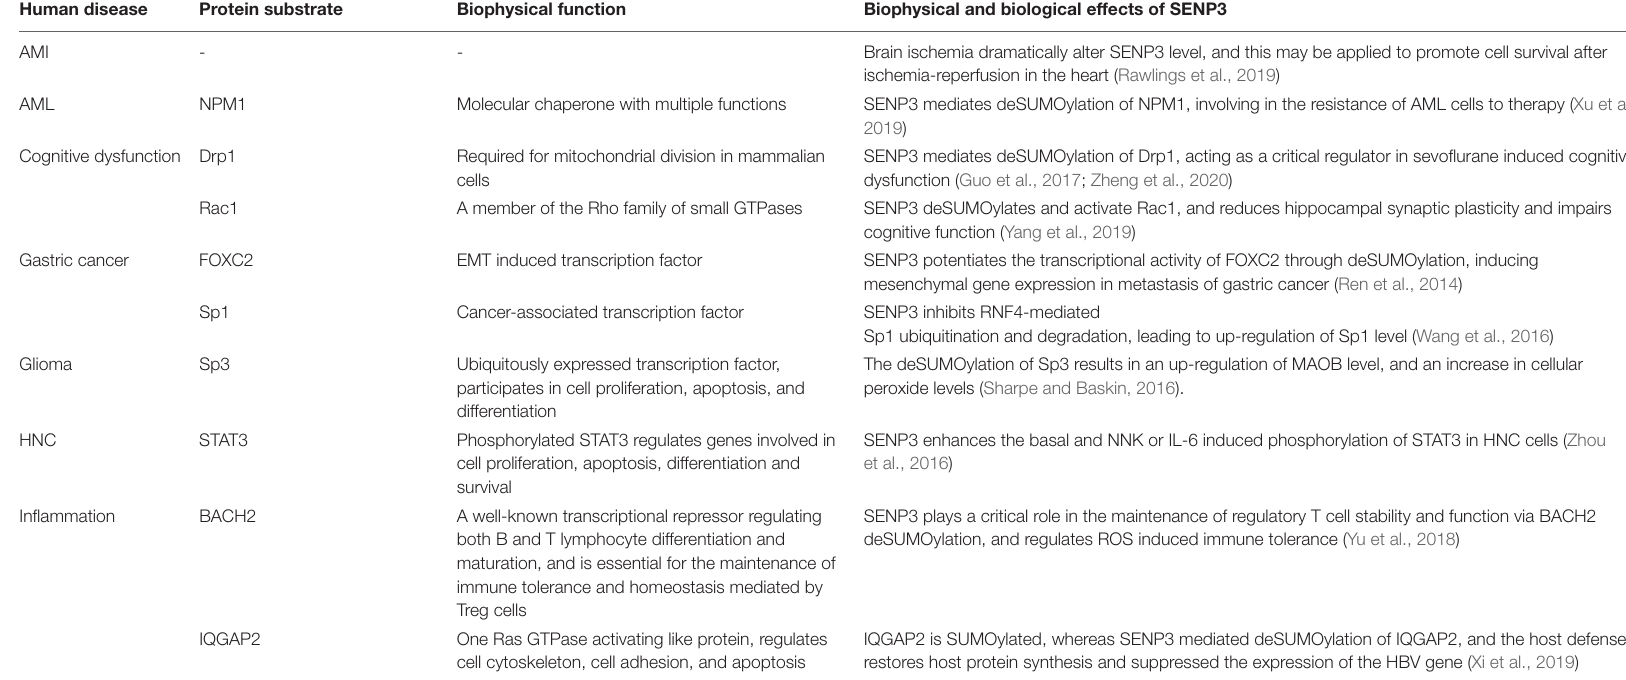
TABLE 1 | Biophysical and biological effects of SENP3-mediated deSUMOylation of protein substrates in human diseases. Human disease Protein substrate Biophysical